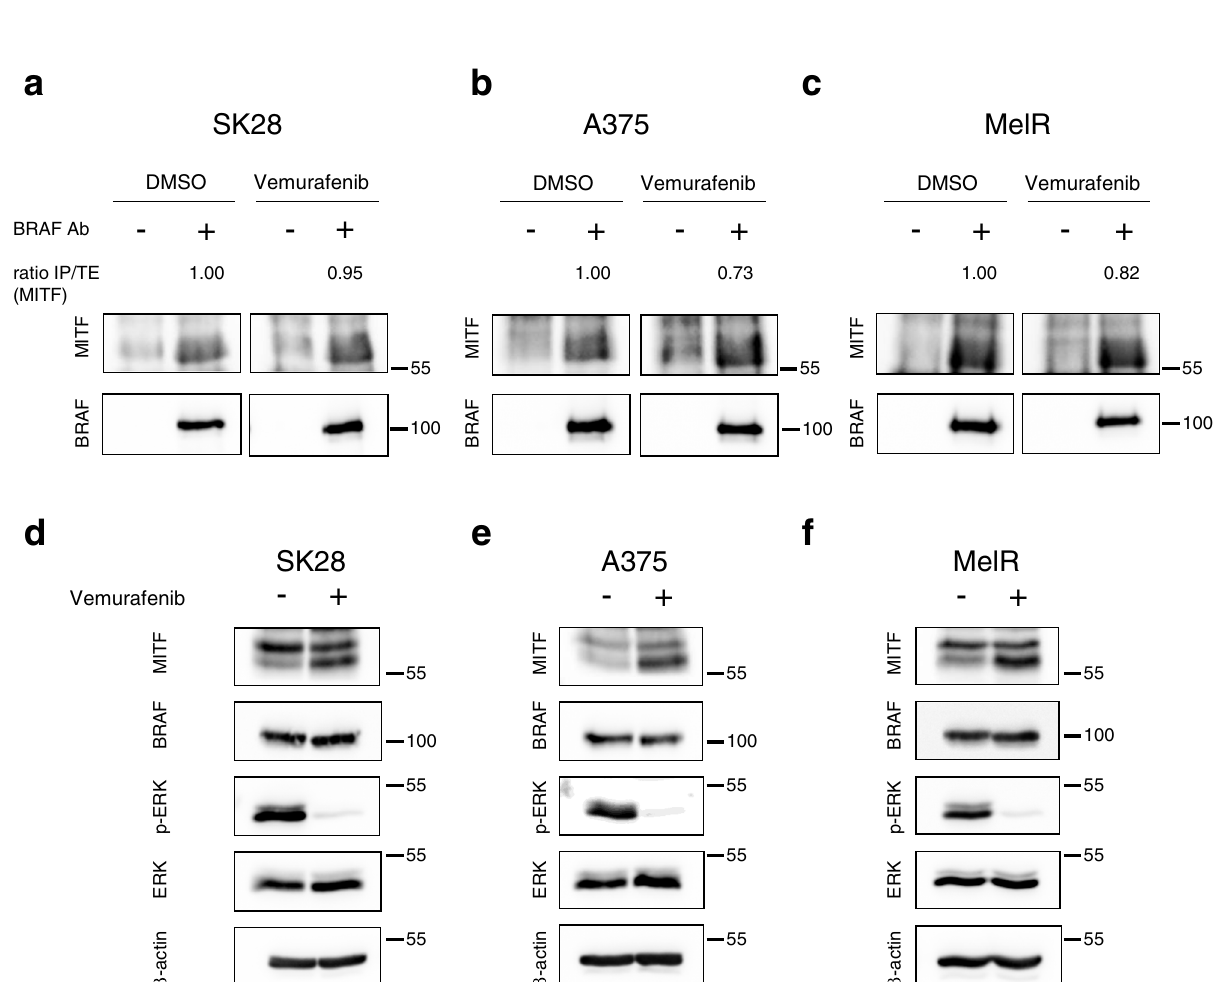
Fig. 4 Identi fi cation of endogenous BRAF/MITF complexes in human melanoma cells. Endogenous BRAF/MITF interaction in BRAF-mutated human melanoma cells. BRAF was immunoprecipitated with an anti-BRAF antibody in SK28 ( a ), A375 ( b ) and MelR ( c ) treated overnight with 1 µ M Vemurafenib or DMSO. Immune complexes were blotted with anti-MITF and anti-BRAF antibodies. Western blot analysis of MITF and BRAF protein expression and ERK activation (pERK) in SK28 ( d ), A375 ( e ) and MelR ( f ) melanoma cells after treatment with 1 µ M Vemurafenib or DMSO. Total ERK and β -actin are used as loading controls. The immunoprecipitated MITF over total MITF ratio (IP/TE(MITF)) was obtained by dividing the MITF signal intensity in immunoprecipitation by the MITF signal in the total extract for each condition. The IP/TE ratio was set to 1 in the DMSO control condition for each cell lines. Coimmunoprecipitations are representative of at least three independent